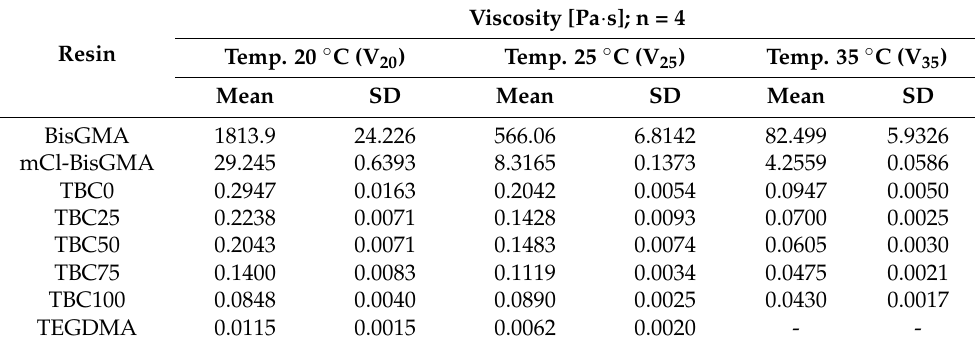
Figure 9. Viscosity curves of BisGMA, mCl-BisGMA, TEGDMA, and resin mixtures TBC0–TBC100 at 35 °C. Table 2. Viscosity of BisGMA, mCl-BisGMA, TEGDMA, and resin mixtures TBC0–TBC100 at